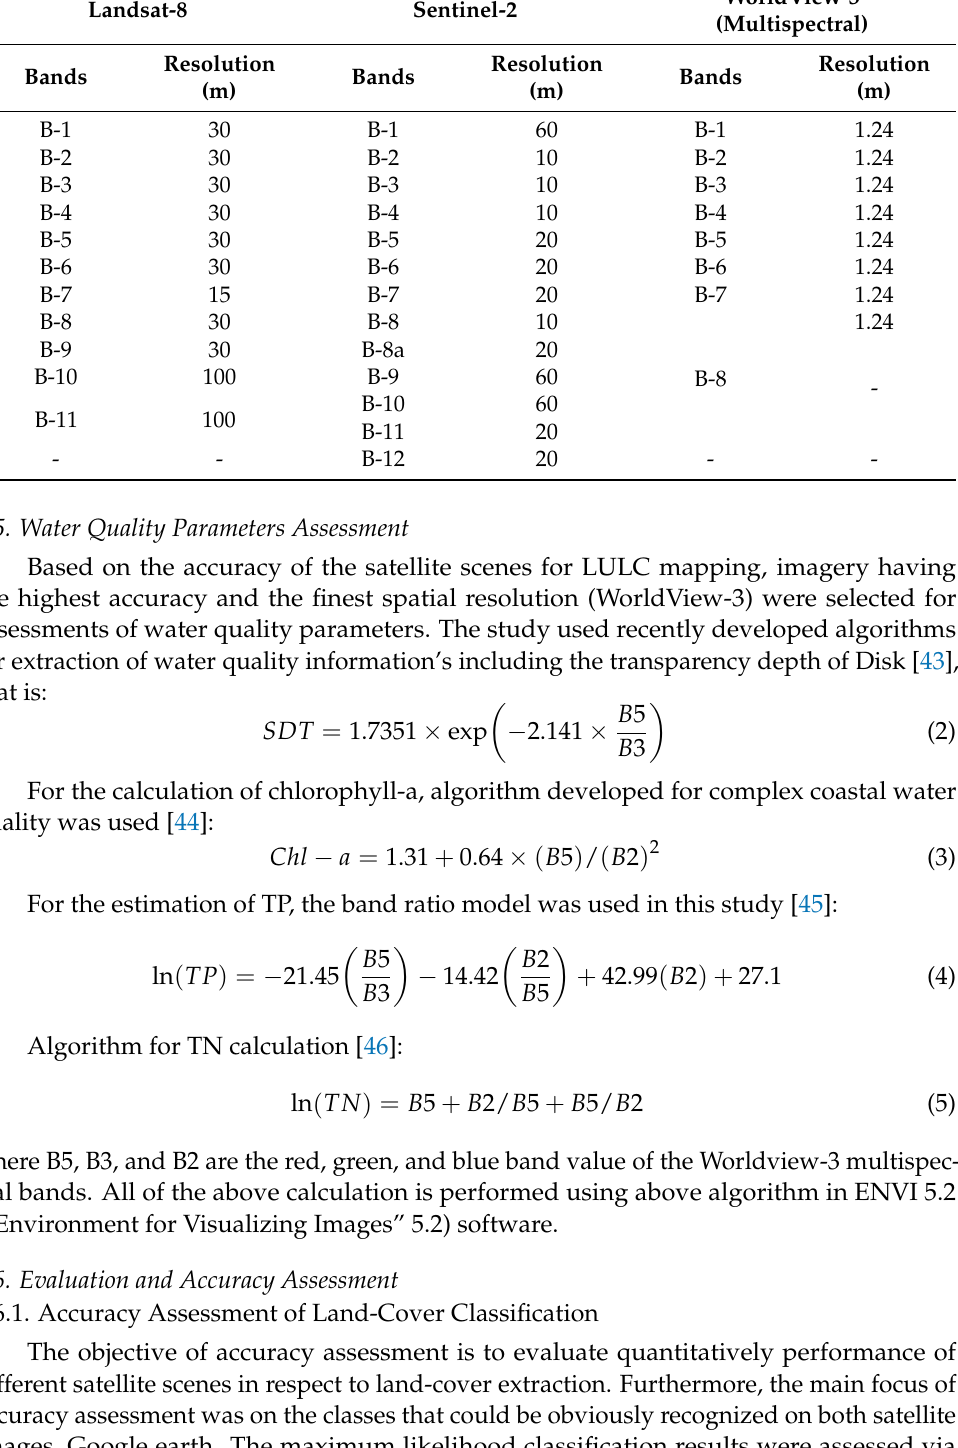
Table 1. Spectral bands and spatial resolutions of the remote sensing datasets. Landsat-8 Sentinel-2